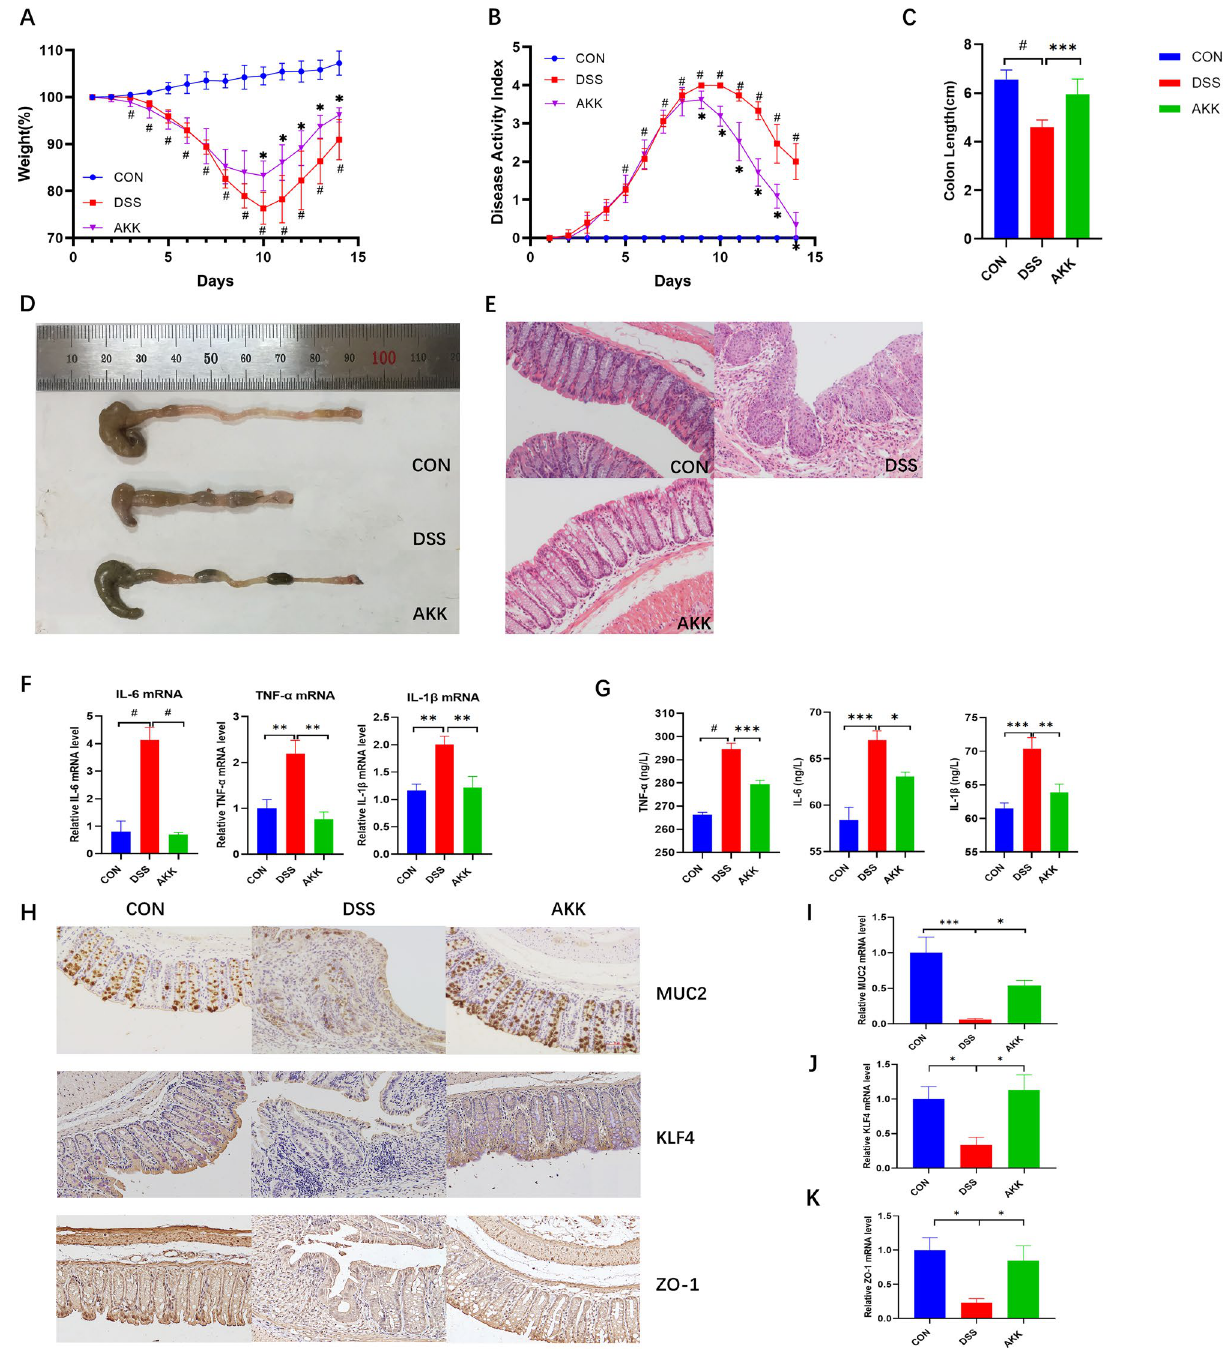
Figure 7. AKK ameliorated the symptoms of DSS‑induced colitis in mice. ( A ) Daily bodyweight changes from day 1 to 14. ( B ) DAI score from day 1 to 14. * P < 0.05, compared with the DSS group; # P < 0.05, CON versus DSS group. ( C ) The lengths of colon. Data are presented as the mean ± S.E.M. and n = 6–8/group. * P < 0.05, ** P < 0.01, *** P < 0.001, # P < 0.0001. ( D ) Macroscopic appearances of colon tissues. ( E ) Histological changes. ( F ) mRNA quantification of proinflammatory cytokines (TNF‑α, IL‑6, IL‑1β) using real‑time RT–PCR. ( G ) Determination of protein production of inflammatory cytokines using ELISA. The data present the mean ± S.E.M. Asterisks denote significance versus DSS group by one‑way ANOVA (* P < 0.05, ** P < 0.01, *** P < 0.001). ( H ) The number of colonic MUC2‑, KLF4‑, and ZO‑1‑positive cells in DSS‑treated mice. Representative images (× 200 magnification, scale bar 50 μm). ( I – K ) mRNA quantification of MUC2, KLF4 and